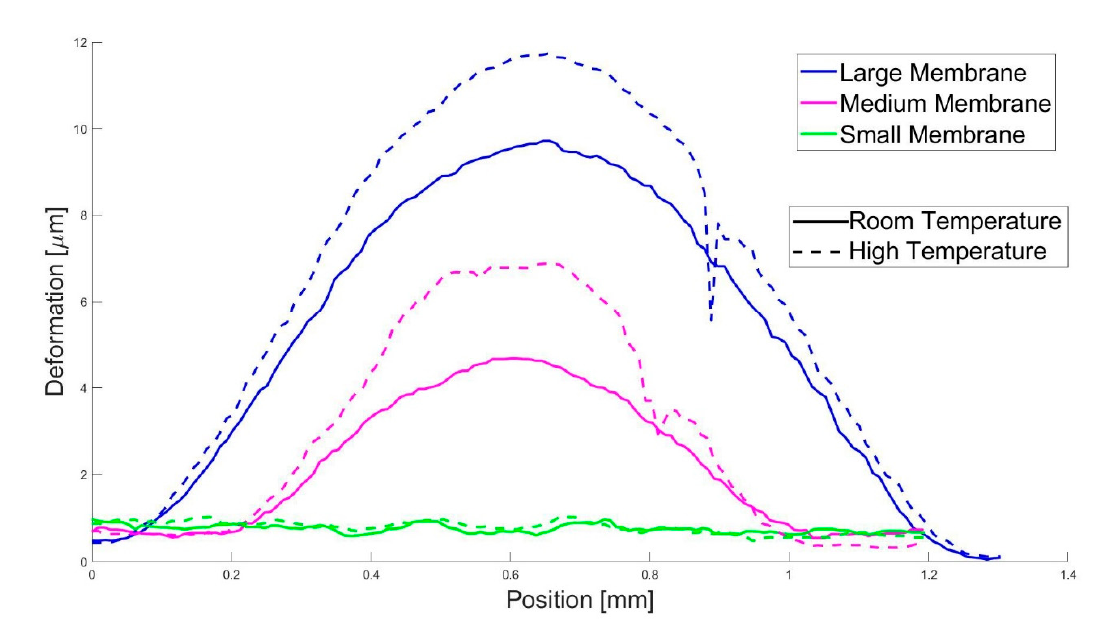
Figure 4. Comparison between the vertical profile in the three flow sensors at room temperature and when biased with 10 mA current. The deformation reduces with the size of the membrane, getting down to effectively zero for the 400 µm one. The temperature gradient due to the current bias increases the